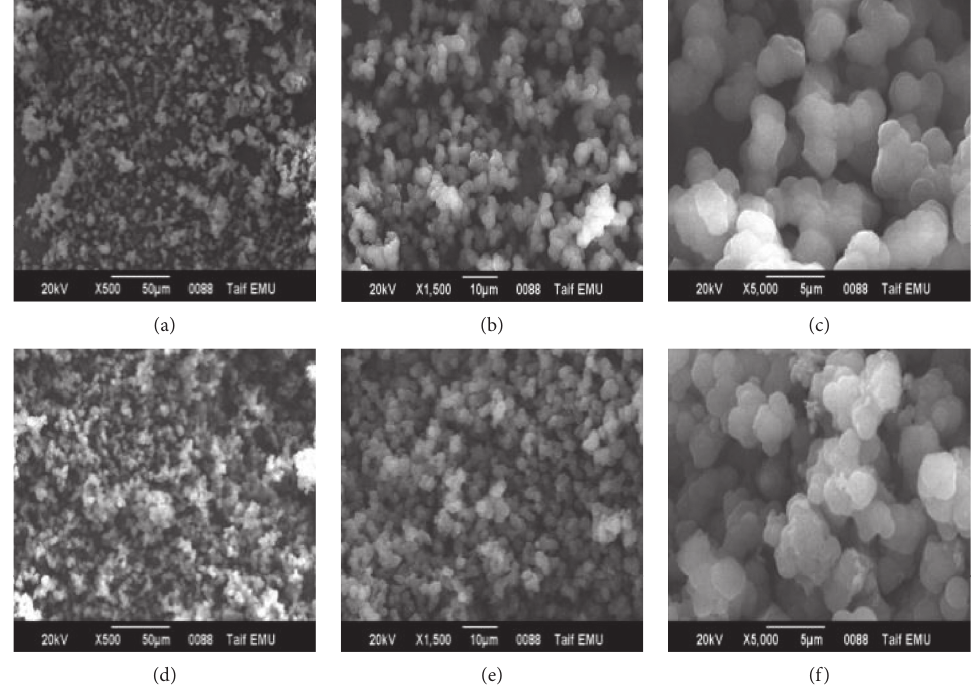
Figure 3: SEM images of the bare organic monolithic rod (a, b, c) and CuBTC-monopol monolith (d, e, f) using different